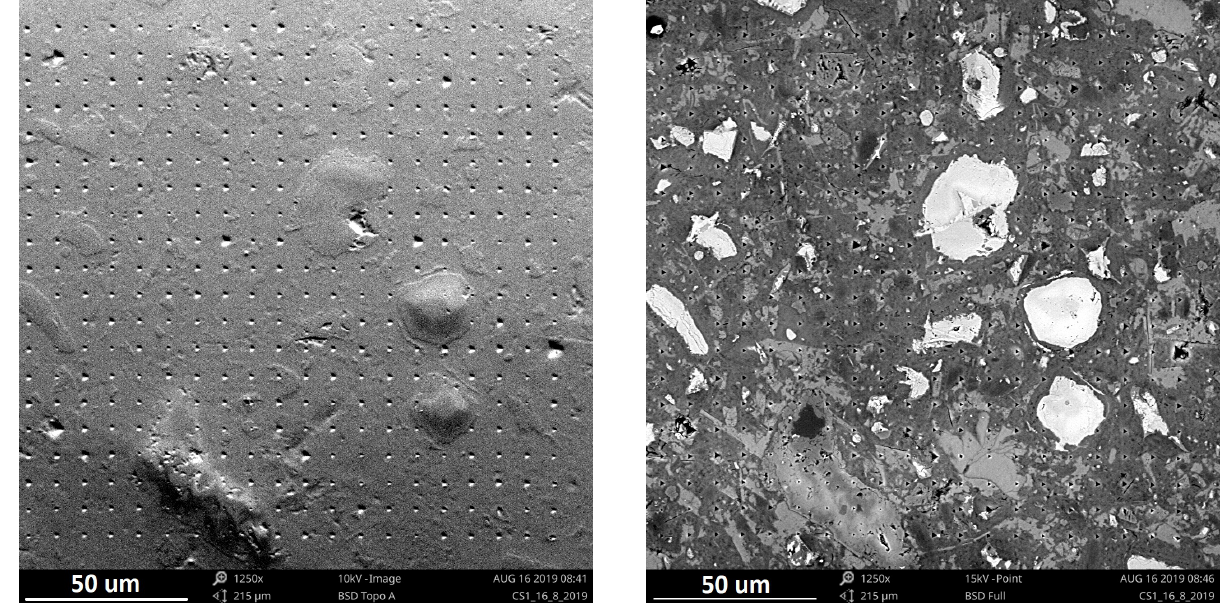
Figure 4. Topography of the surface.